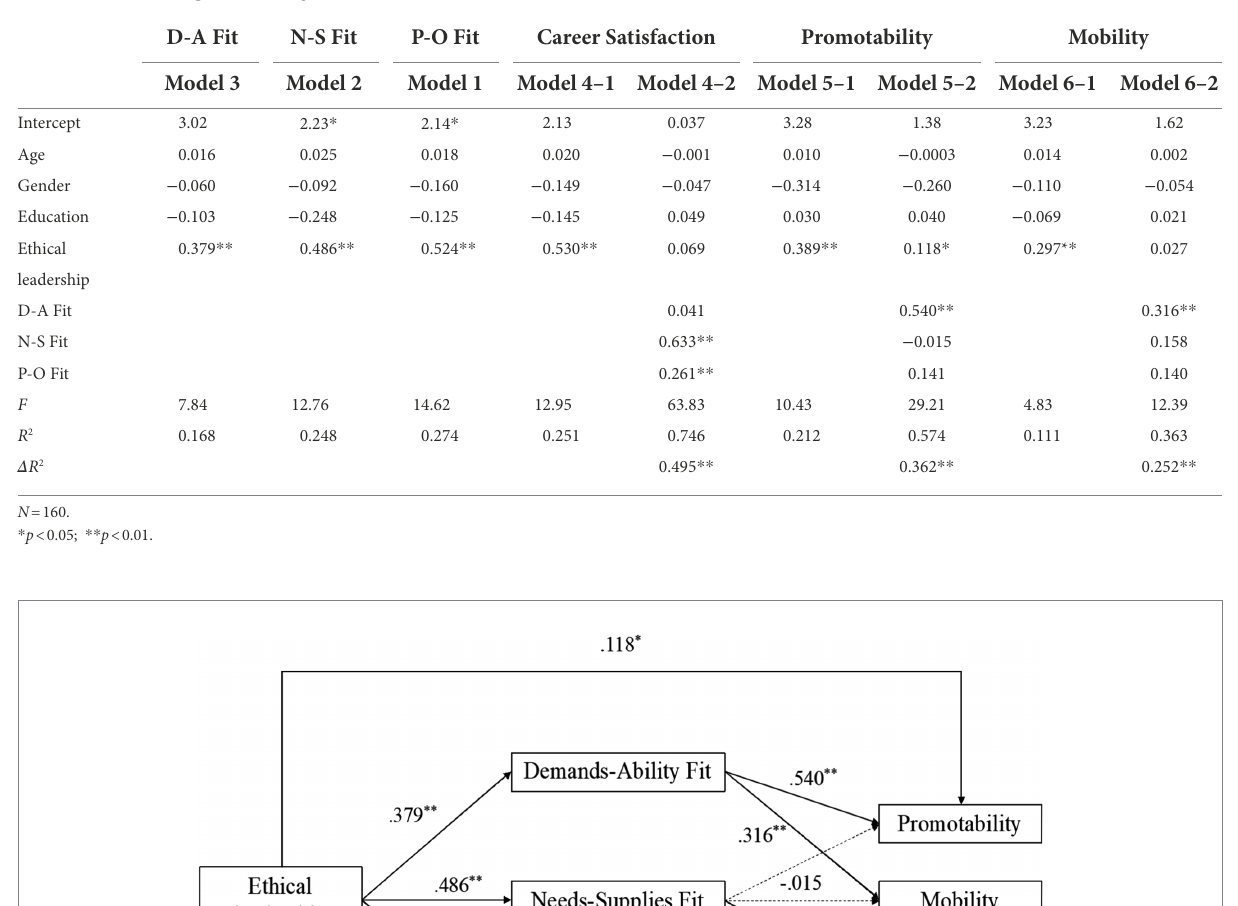
TABLE 3 Results of regression analysis.